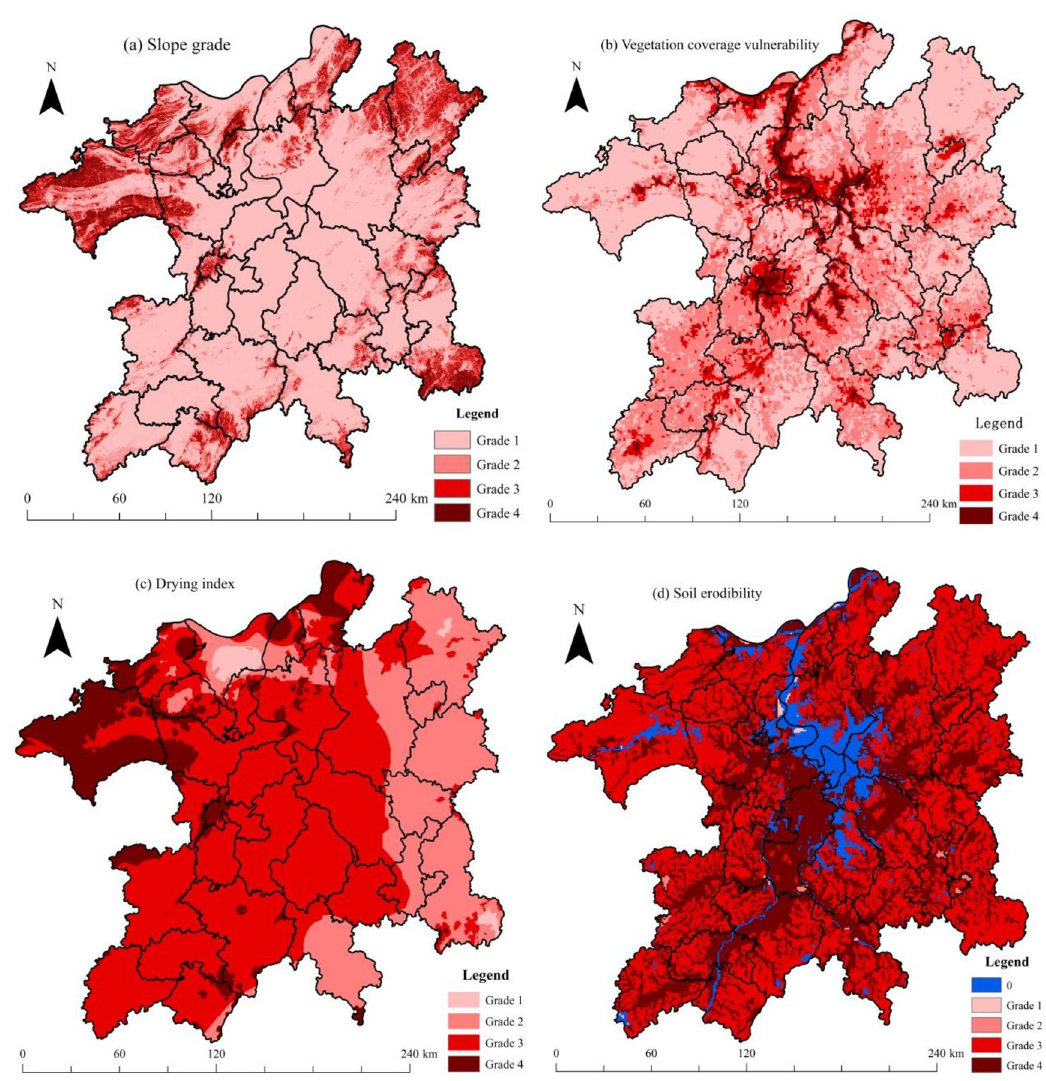
Fig 7. Grades of vulnerability factors in the PLEZ in aspects of (a) slope, (b) NDVI, (c) drying index, and (d) soil